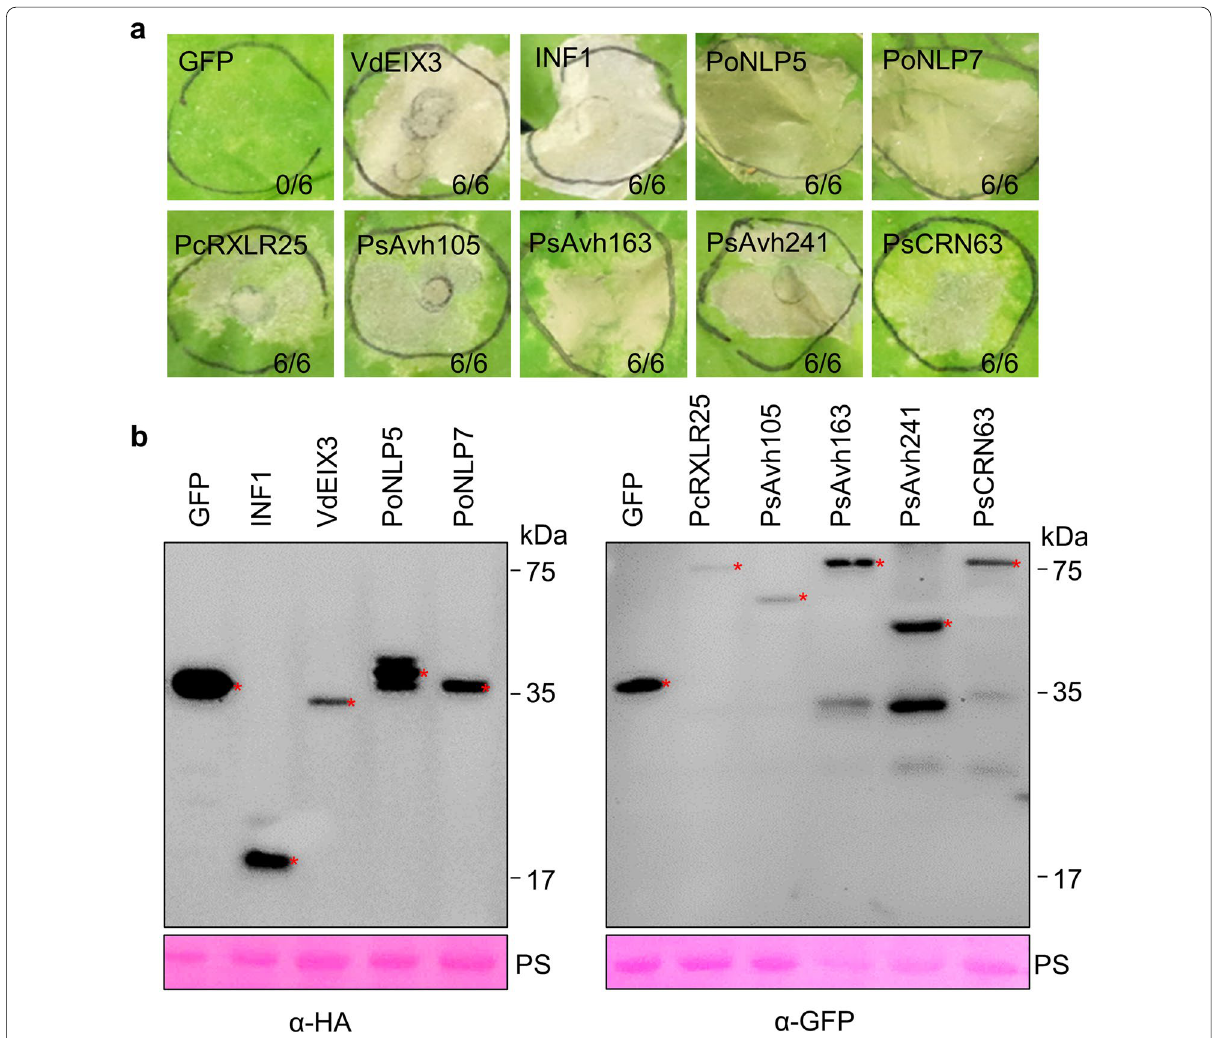
Fig. 1 Eight oomycete effectors cause HR-like phenotype in N . benthamiana. a Ectopic expression of eight effectors in N. benthamiana . Transient expression of VdEIX3, INF1, PoNLP5, PoNLP7, PcRXLR25, PsAvh163, PsAvh241 and PsCRN63 in N. benthamiana . GFP was used as a negative